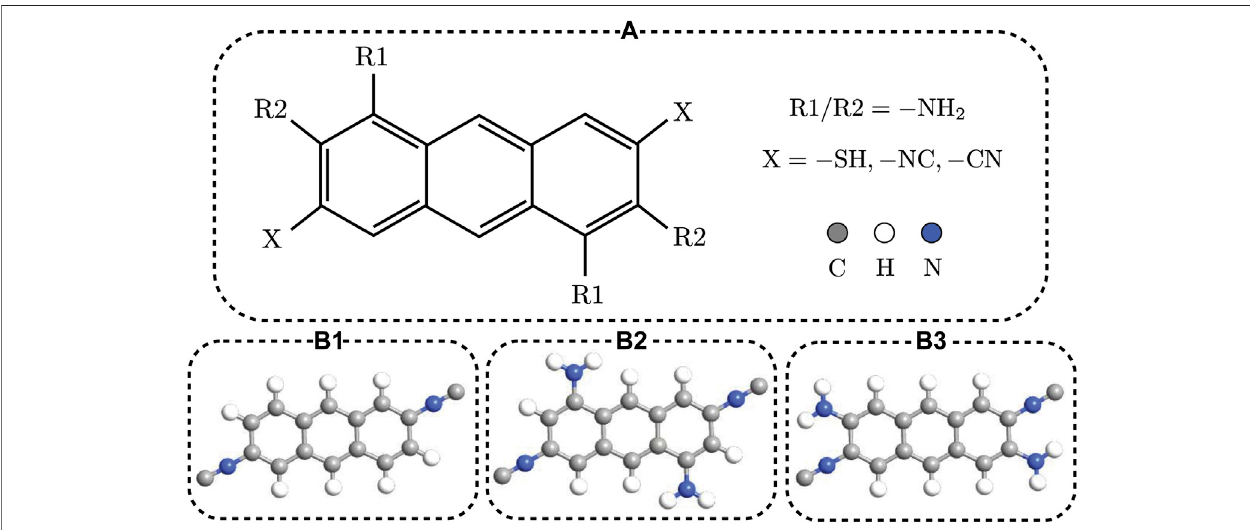
FIGURE 1 | (A) Schematic representation of the anthracene molecule terminated with anchoring groups X (cid:1) thiol ( − SH), isocyanide ( − NC) or cyanide ( − CN), and functionalized with the amine ( − NH 2 ) side group in the R1/R2 position. (B1-B3) Examplary model of the unperturbed isocyanide-terminated anthracene molecule (B1), and the same molecule perturbed with the amine side group in R1 (B2) and R2 (B3) positions.